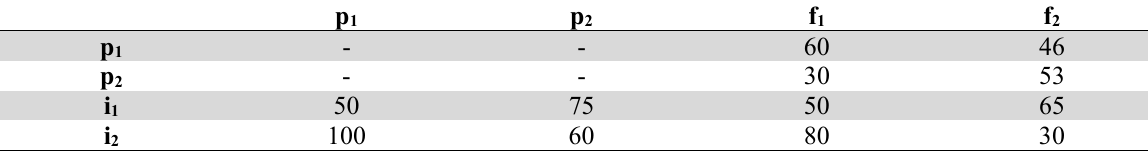
Distances between nodes (in kilometers)